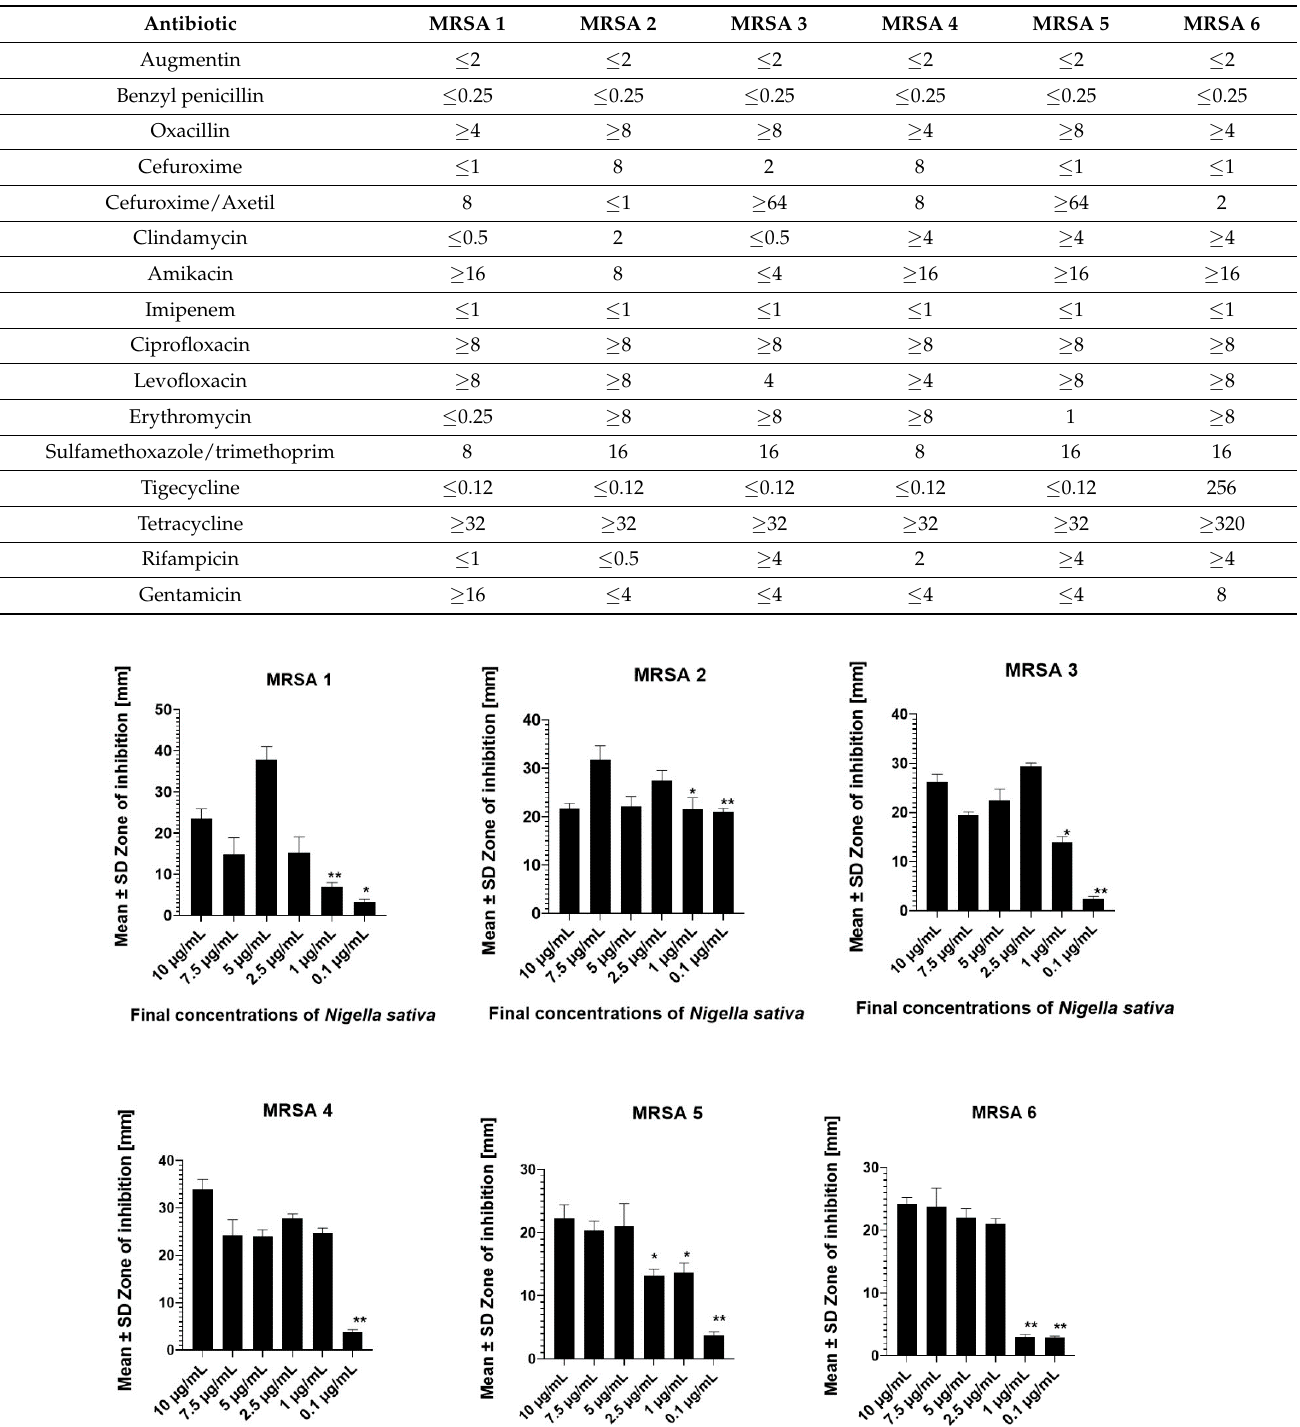
Table 1. Minimum inhibitory concentration of the MRSA isolates against tested antibiotics.